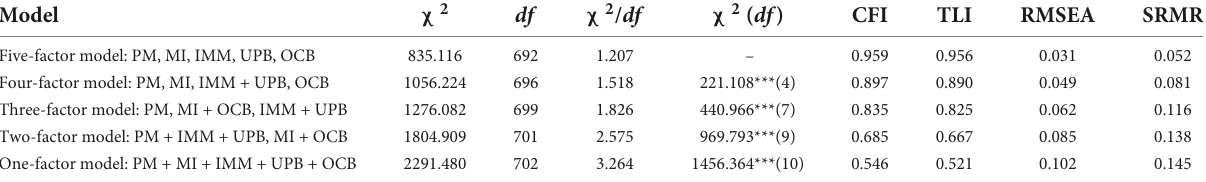
TABLE 1 The results of confirmatory factor analyses.